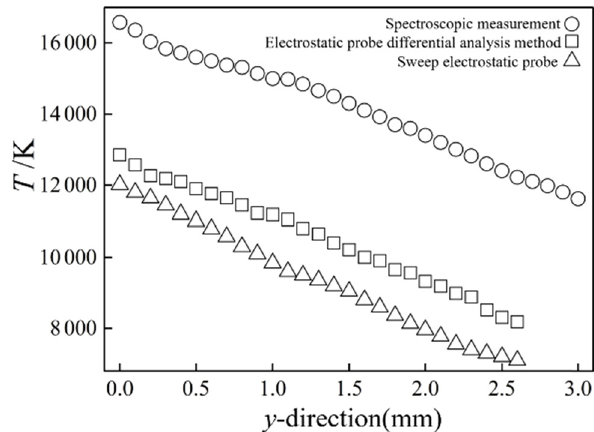
Figure 6: Radial distribution of temperature in the current - carrying region 3 mm from the arc surface, welding current 100 A, and arc length 5 mm.